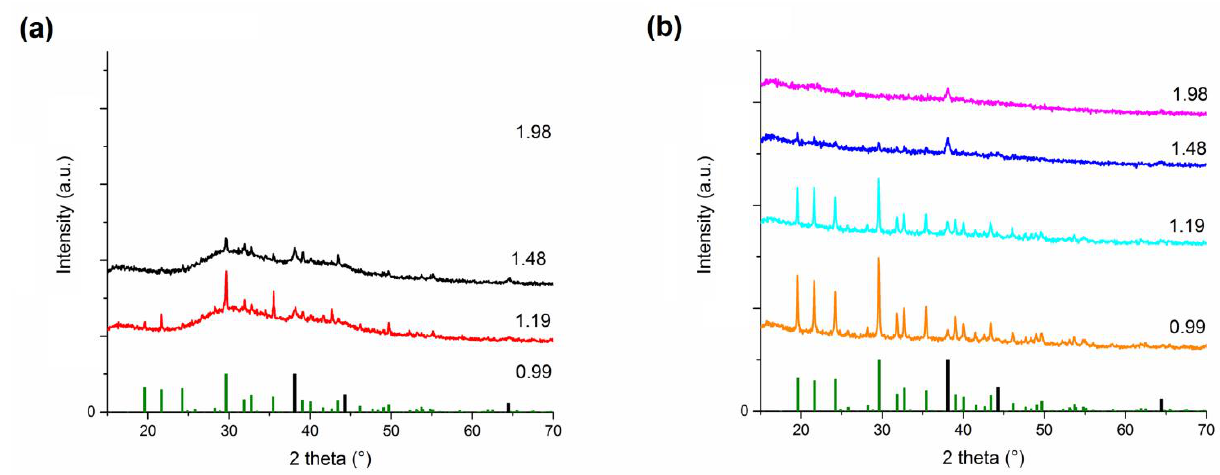
Figure 6. XRD patterns of the dried reaction mixtures after the green synthesis ( a ) and as-milled powders after the mechanochemical synthesis ( b ) using the four highest lavender:AgNO 3 mass ratio. At the bottom, green bars correspond to orthorhombic AgNO 3 (ICDD 74-4790) and black to cubic Ag (ICDD 65-2871).